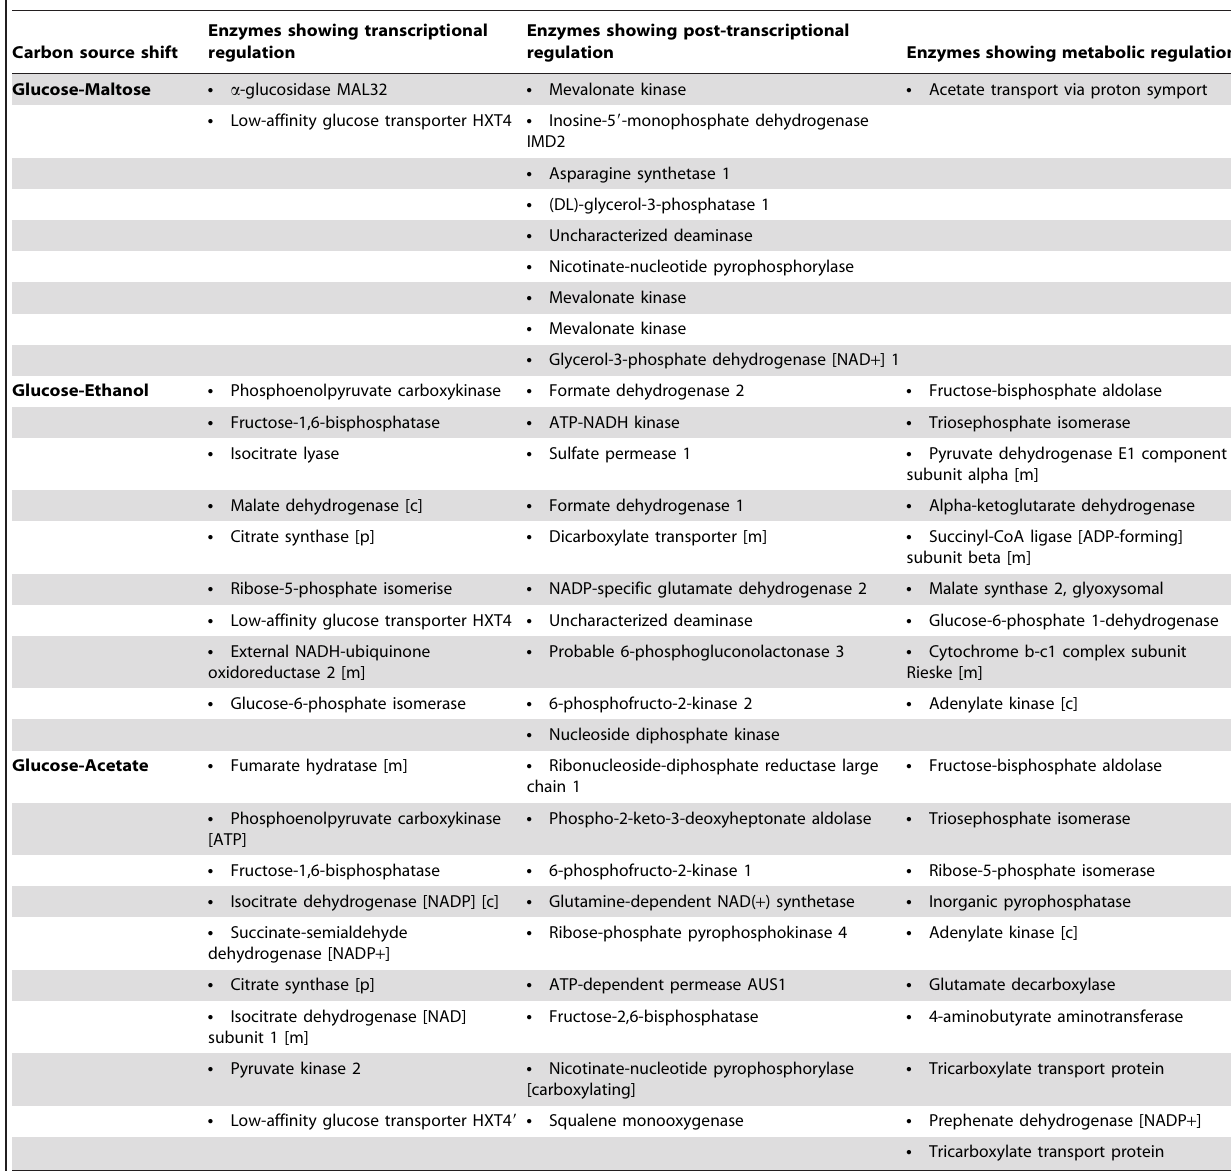
Table 2. Top scoring enzymes for transcriptional, post-transcriptional and metabolic regulation for changes in carbon source.